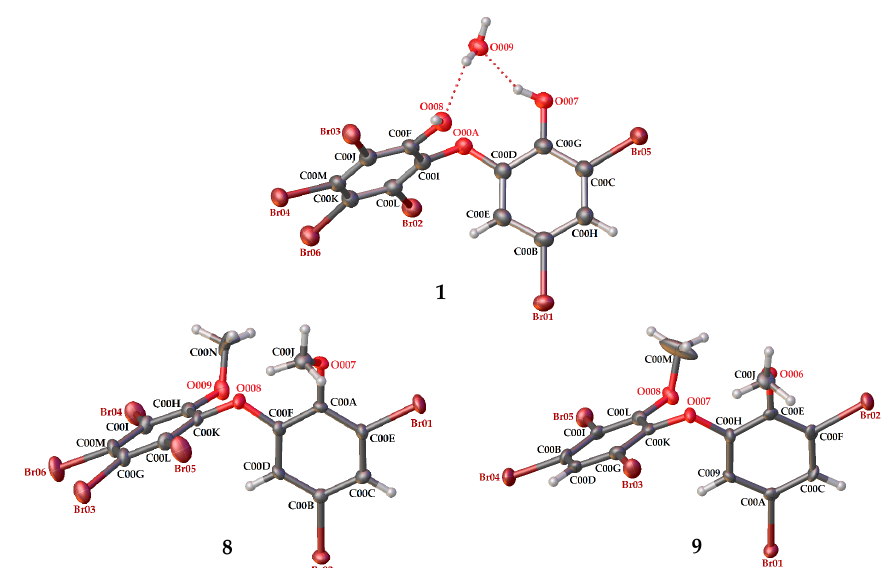
Figure 3. Crystal structures of 1 , 8 and 9 with displacement ellipsoids drawn at the 50% probability level. The crystal structure of 1 is presented to compare the material for structure modification with two phenolic groups and debromination.